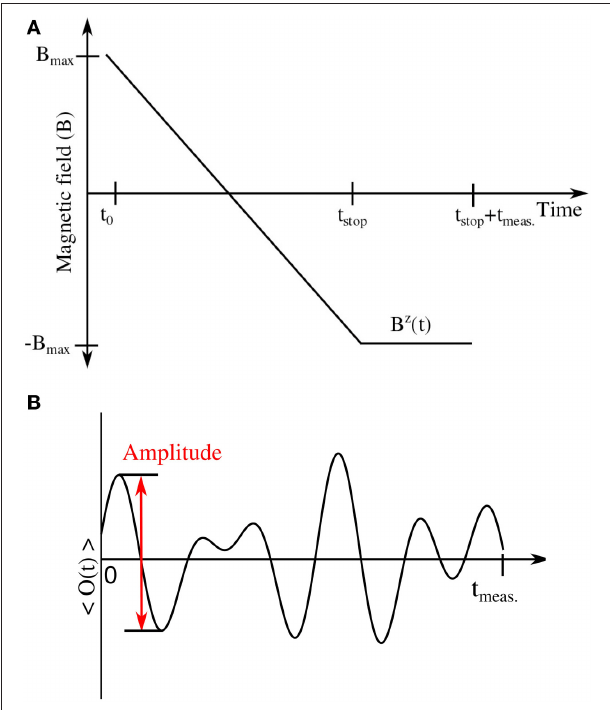
FIGURE 3 | Schematic diagram of the experimental protocol. (A) The transverse magnetic field as a function of time is diabatically ramped down to a chosen value, B z ( t stop ) . B z ( t stop ) is then held for a time interval of t meas . . (B) An observable is measured at the end of the interval t meas . . The amplitude of the oscillation is taken, for simplicity, to be the amplitude of the initial oscillation after t stop